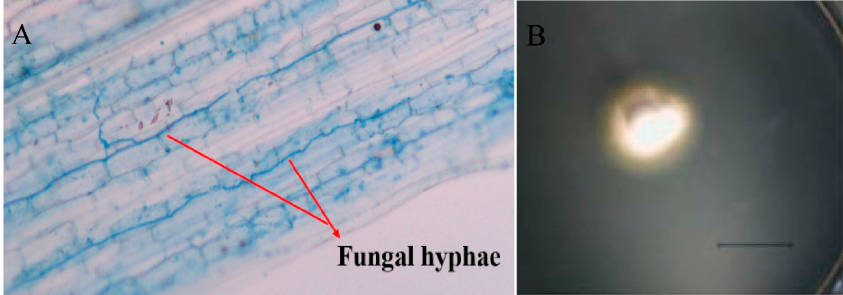
Figure 1. Hyphae in leaf sheath ( A ) (Shot under 4 × microscope) and colony ( B ) of Epichloë bromicola isolated from Leymus chinensis . Picture of colony was taken after growing on PDA for 10 days (scale bars = 10 mm).